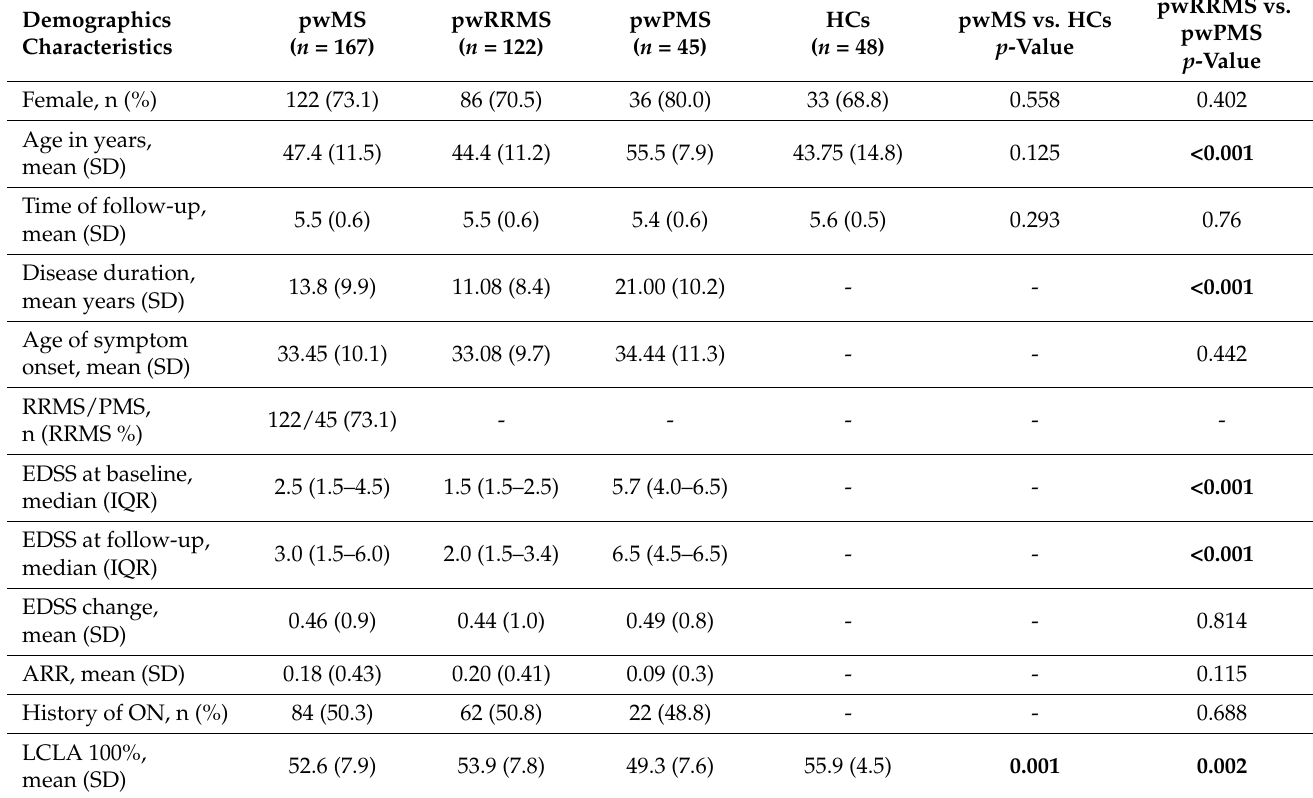
Table 1. Demographic and clinical characteristics of the study population at baseline